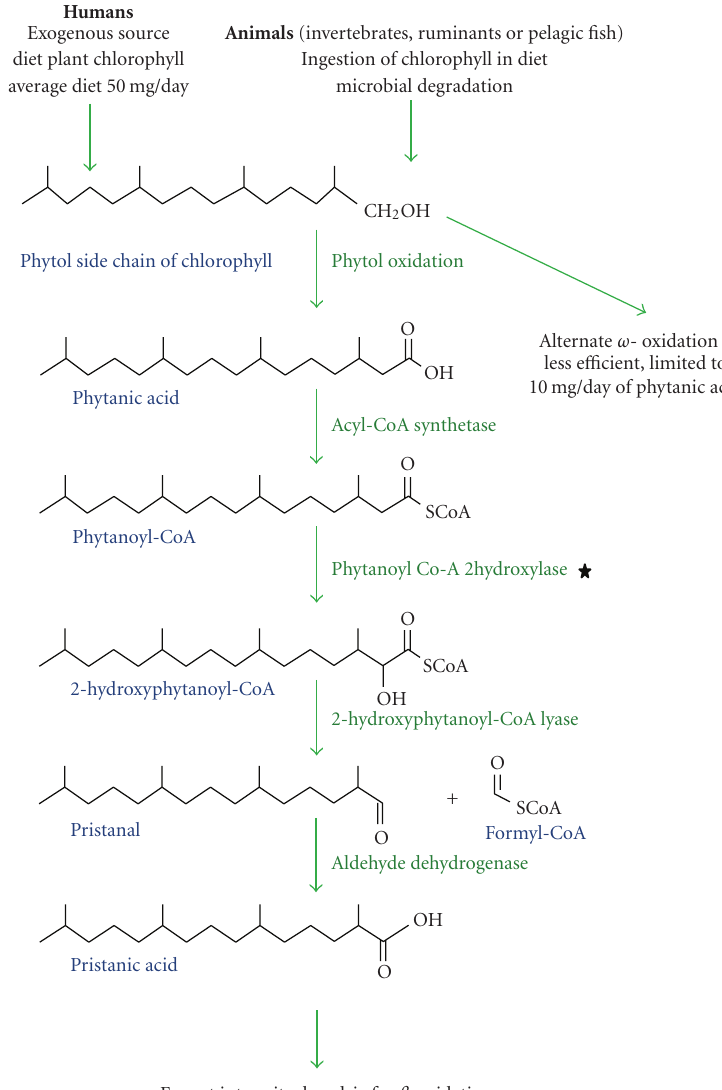
Figure 1: Metabolic pathway of phytanic acid. Phytanic acid is derived from microbial degredation of the phytol side chain of chlorophylls ingested by ruminants, invertebrates, or pelagic fish. In humans the source is phytol from diet chlorophyll, or from meat, pelagic fish, or diary. When digested it is in-cooperated into chylomicrons/VLDL and then transported to liver and tissues for further metabolism. Most fatty acids are metabolised by β -oxidation pathways in peroxisomes and mitochondria. (cid:2) denotes the enzyme deficient in patients with Refsum disease. # denotes the alternate less e ffi cient ω -oxidation